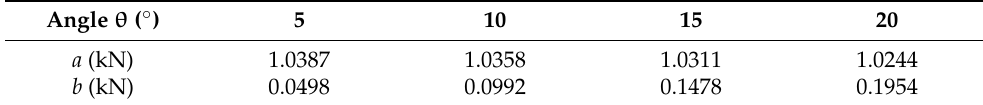
Table 3. Calculated a and b under different inclination angles of the container.